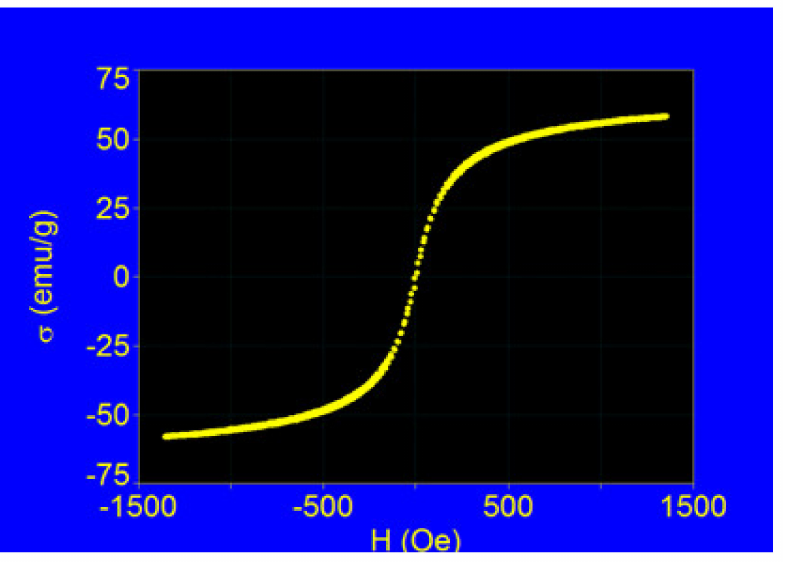
Figure 10. Magnetization curve of the Fe 3 O 4 -PAA nanoparticles in the external magnetic